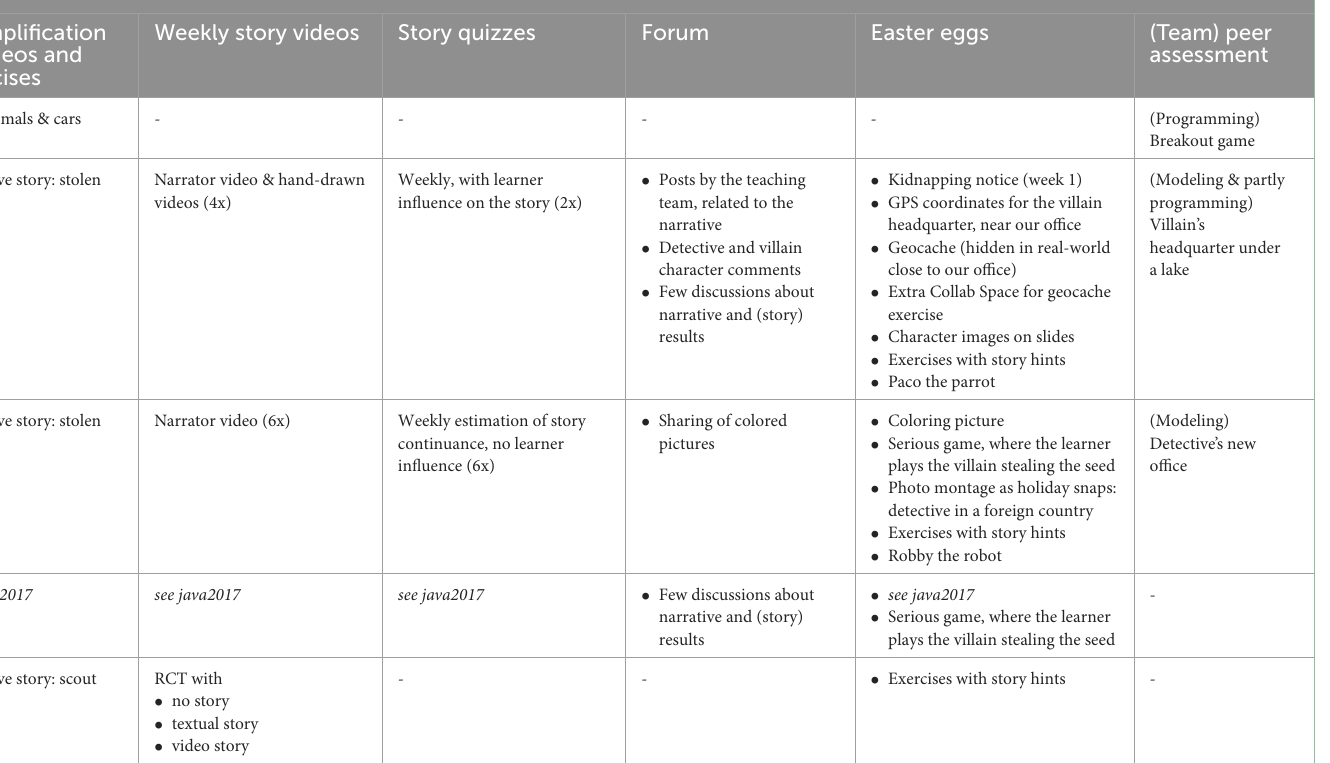
TABLE 1 Story and game elements in all iterations of the Java OOP Programming MOOCs. Course, platform, language,